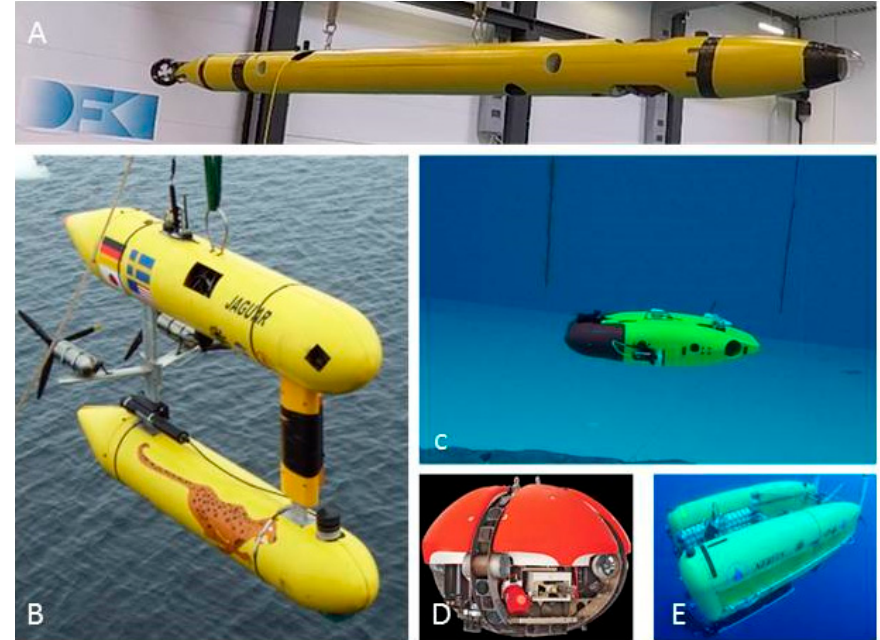
Figure 4. Illustration of different AUV concepts: ( A ) torpedo-shaped Leng (top); ( B ) vertical catamaran SeaBED-Class; ( C ) horizontal catamaran with hydrodynamic hull Dagon; ( D ) circular hulled DepthX; ( E ) hybrid ROV/AUV Nereus (non-extant). J. Mar. Sci. Eng. 2016 , 4 , 36